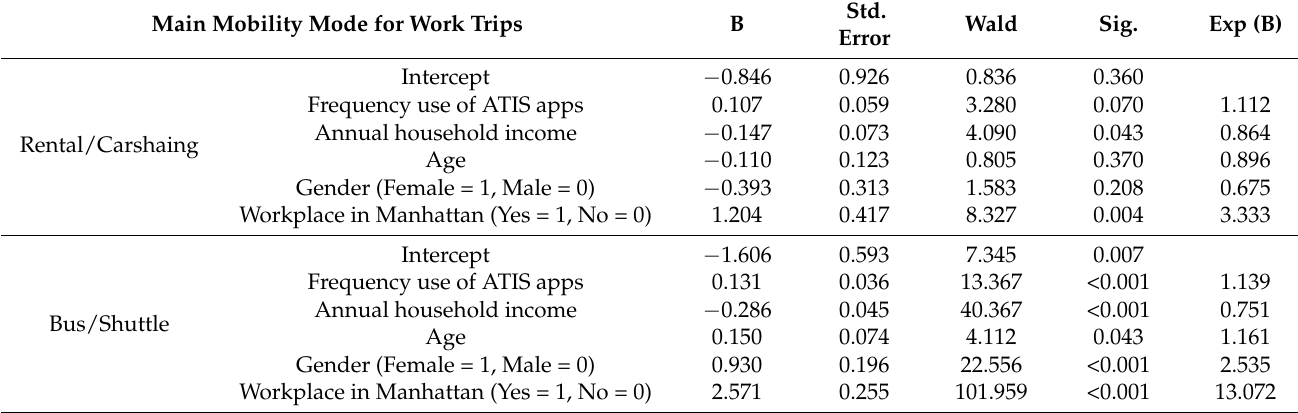
Table 2. Multinomial logit model for the main mobility mode for work